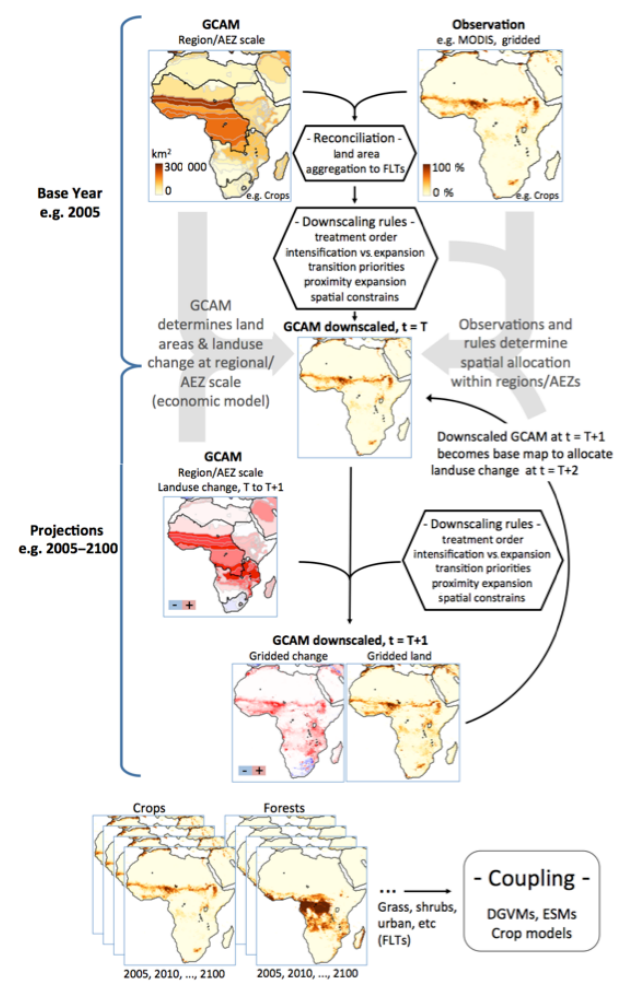
Figure 3. Overview of the downscaling method. The figure shows the successive computational steps to downscale a LULC change scenario from 2005 to 2100 described in the text (Sect. 3). The rec- onciliation phase is detailed in Sect. 3.1; The downscaling rules are detailed in Sect. 3.2, including the treatment order (Sect. 3.2.1), in- tensification vs. expansion ratio (Sect. 3.2.2), the transition priori- ties (Sect. 3.2.3), and the spatial constrains (Sect.